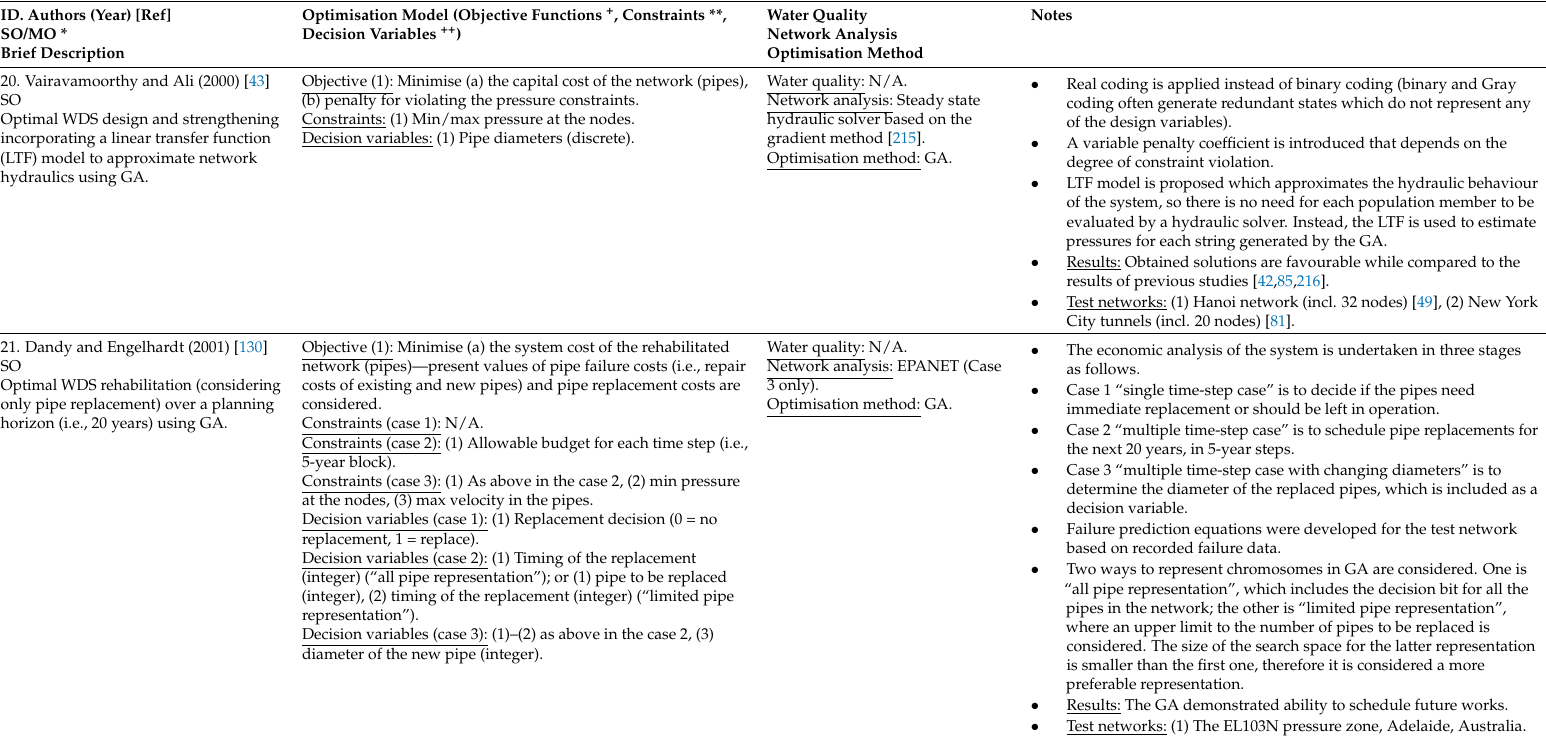
20. Vairavamoorthy and Ali (2000) [43] SO Optimal WDS design and strengthening incorporating a linear transfer